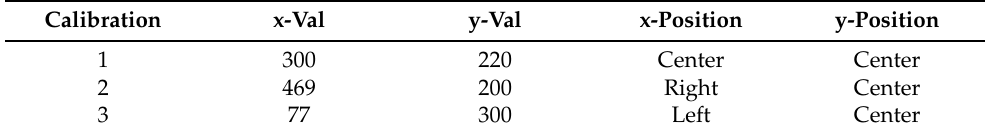
Table 2. The result of the object coordinate